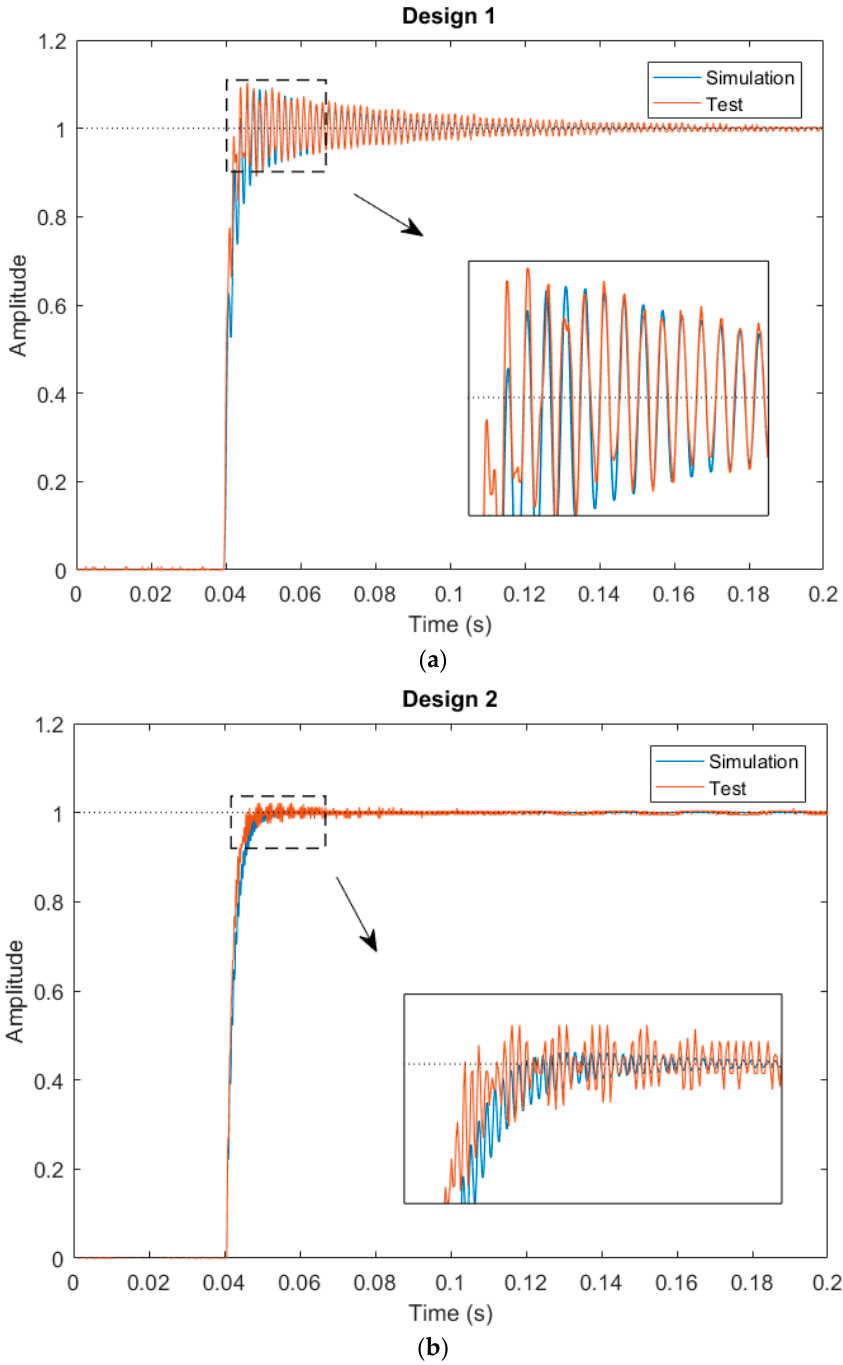
Figure 10. Step responses of the MEMS mirrors. ( a ) Design 1; ( b ) Design 2.